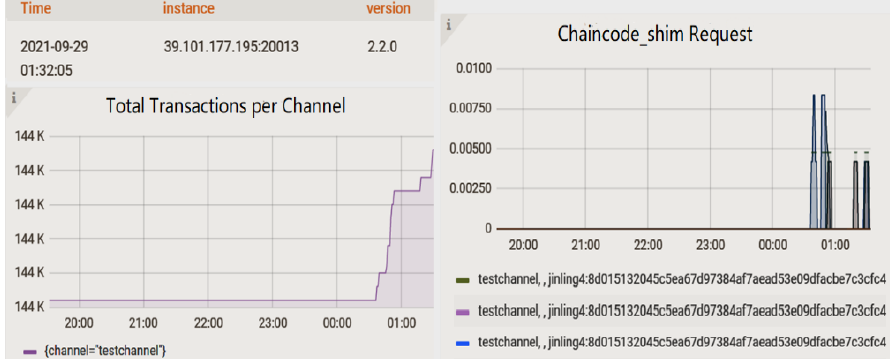
Figure 6. Instance of smart contract transaction.